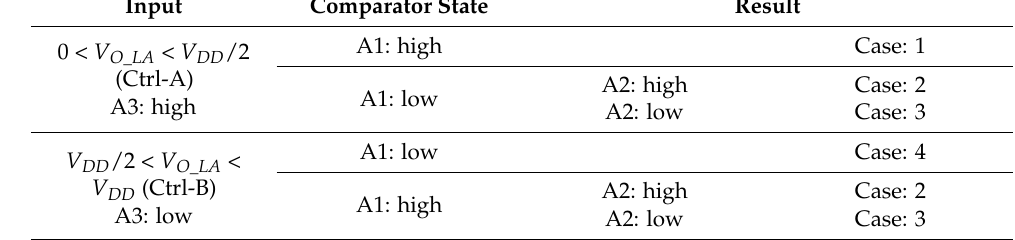
Figure 10. Circuit structure of the hysteretic control loop.